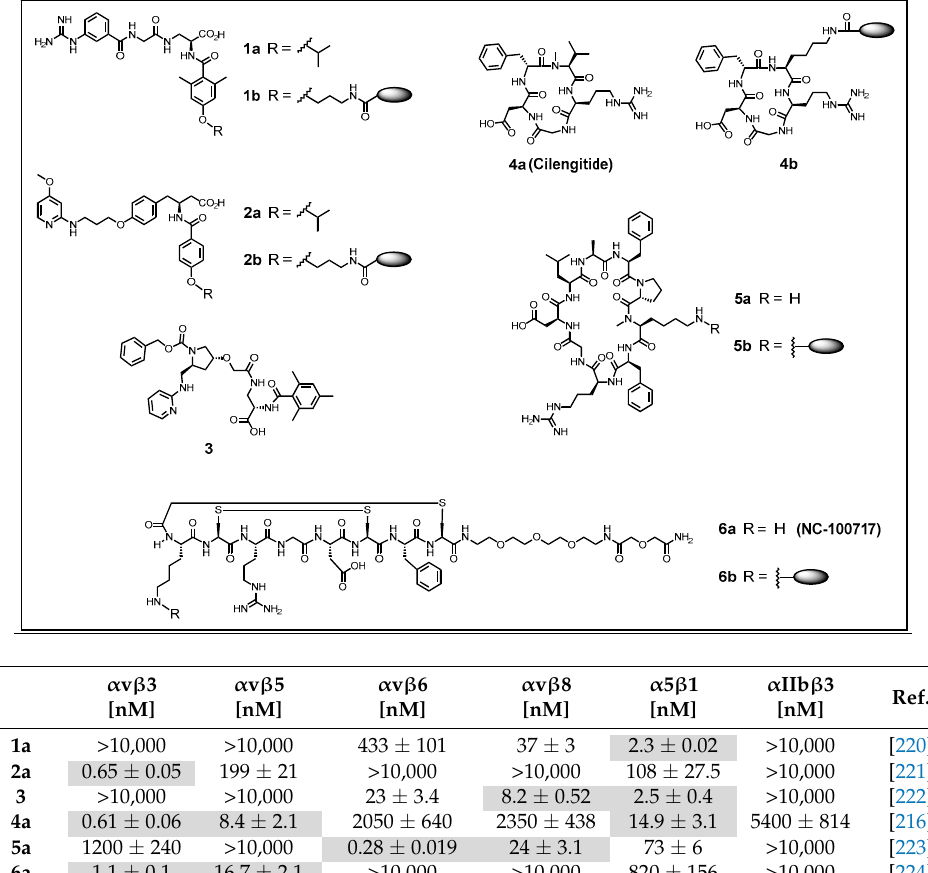
Figure 3. Development and testing of selective integrin ligands. Depicted are some integrin-specific ligands according to their selectivity profile (IC 50 -values) for the subtypes α v β 3, α v β 5, α v β 6, α v β 8, α 5 β 1, and α IIb β 3 [214]. The binding affinities of the ligands have been determined in a cell-free, enzyme-linked immunosorbent assay (ELISA)-like assay for comparability. None of the selected compounds has significant affinity for the platelet integrin α IIb β 3. Specificity or subtype with the lowest IC 50 -values are highlighted. The preferential site for modification with diagnostic or therapeutic agents is indicated by an ellipsoid tag.